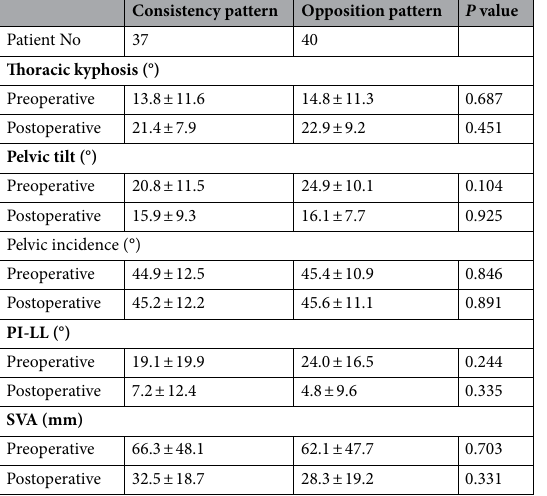
Table 4. Pre-and post-operative sagittal parameters between two groups (independent t test). PI-LL pelvic incidence minus lumbar lordosis, SVA sagittal vertical